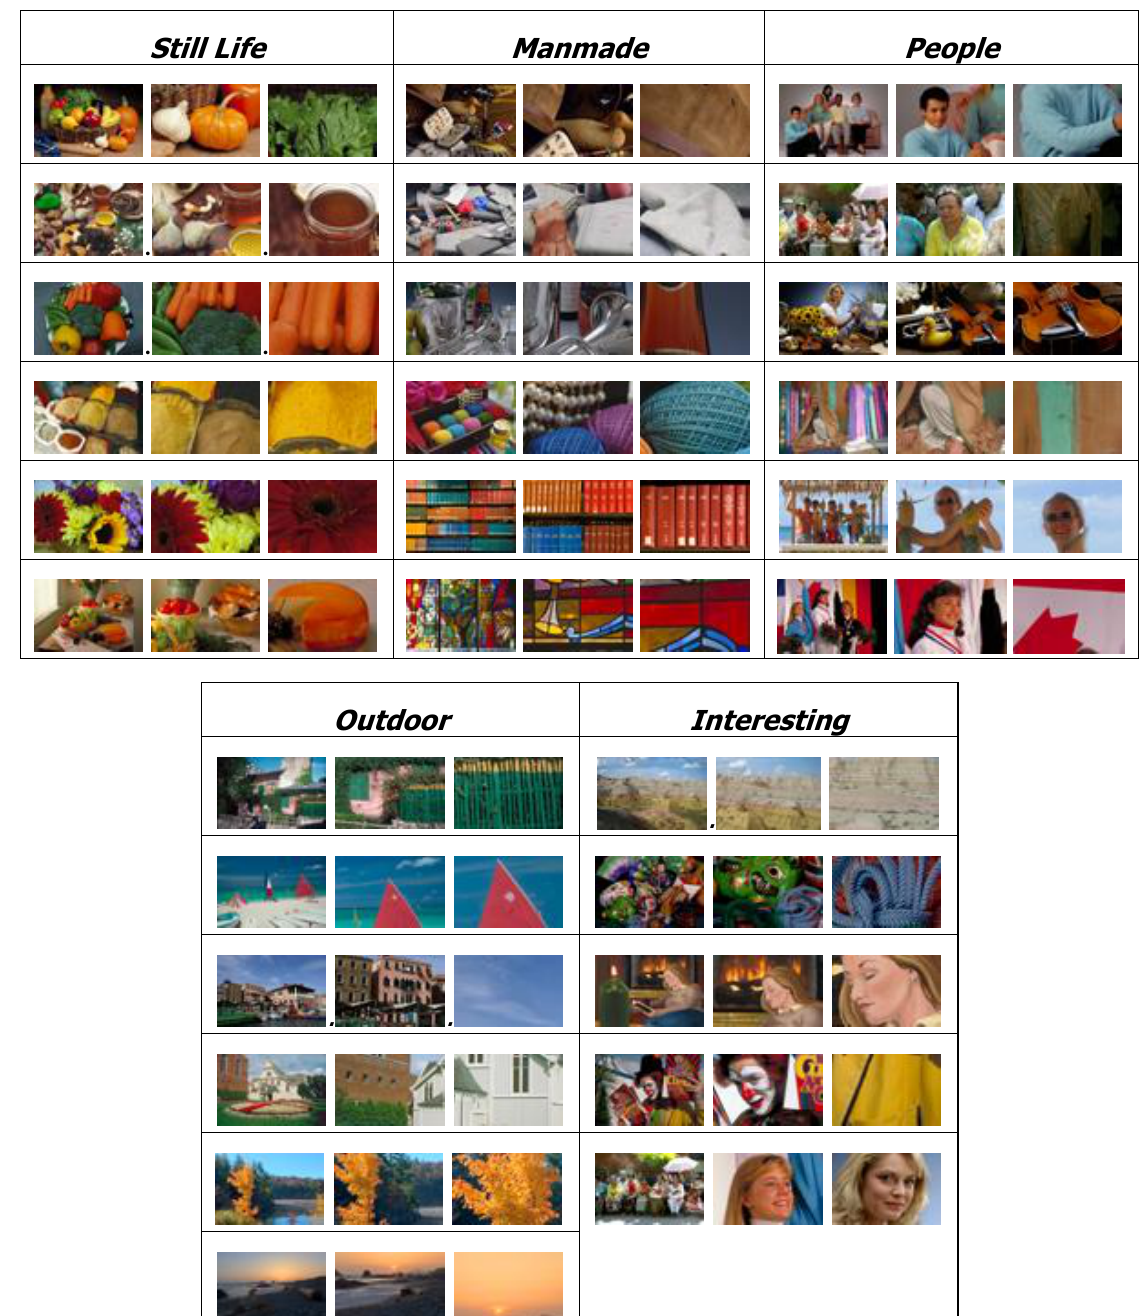
Figure 3: Images used in Farnand, 2013. For each scene, the full scene, a mid-cropped, and a closely-cropped rendition were in- cluded. The majority of the scenes were obtained from RIT’s Corel® image database. Lexmark ® contributed the Paint Girl scene, Row #3 in the People category. The last two scenes in the Outdoor category and the first in the Interesting category are images from Dr. Mark Fairchild’s HDR image database. The Firelight scene, third row in the Interesting category, was a painting (artist un- known) included in a study of fine art reproduction processes. And the scenes in the first four rows of the Manmade category and the second in the Interesting category are images included in international standards for assessing image